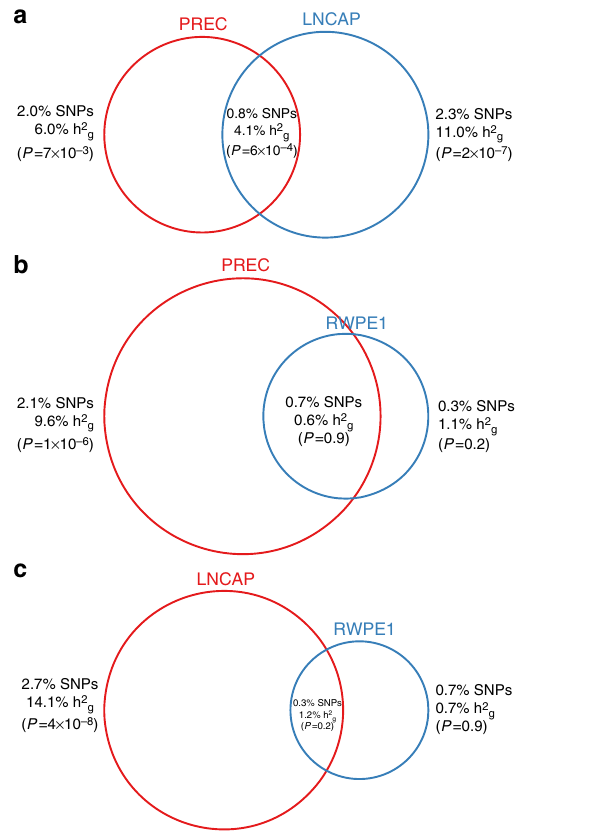
Figure 3 | Pairwise analysis of DHS marks in three prostate cell types. Joint model from all pairs of DHS marks shown for: cancer cell line (LNCAP); normal prostate epithelial (PREC); and immortalized prostate epithelial (RWPE1). Circle size corresponds to % SNPs, with % SNP heritability and significance labelled. P value was computed for difference between %h 2 and %SNP, with bold representing significance after g correcting for nine tests. The observed trend is LNCAP 4 PREC 4 RWPE1: in LNCaP DHS was nominally significantly higher than PrEC ( a ) %h 2 g in LNCaP and PrEC was significantly higher than ( P ¼ 0.01); and %h 2 g RWPE1 ( b , c ; P ¼ 1.5 (cid:2) 10 (cid:3) 9 , P ¼ 1.2 (cid:2) 10 (cid:3) 5 , respectively). All P values estimate and analytical standard error. computed by Z -test using %h 2 g